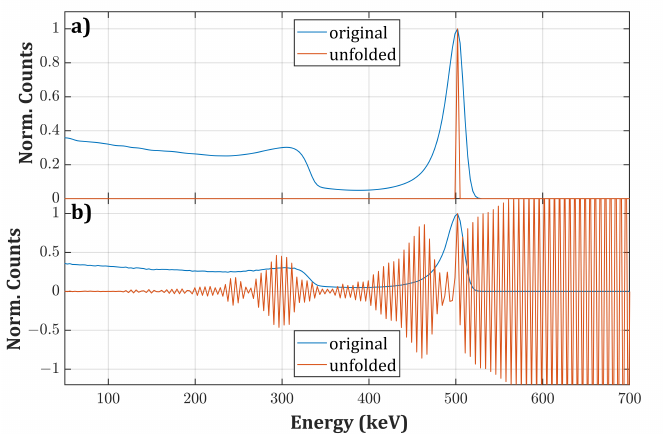
Figure 1. ( a ) Ideal synthetic spectrum (i.e., a column of R ) for a monoenergetic radiation of 500 keV (blue curve) and the corresponding unfolded spectrum after applying R − 1 (orange curve); ( b ) same spectrum after adding a slight Gaussian noise (blue curve) and the corresponding unfolded spectrum after applying R − 1 (orange